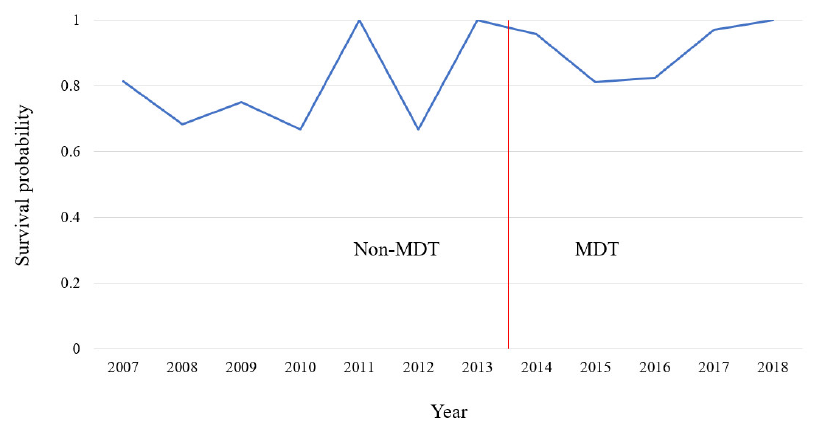
Figure A4. 1-year survival rate for overall patients who underwent heart transplantation from 2007 to 2018. MDT, multidisciplinary team.